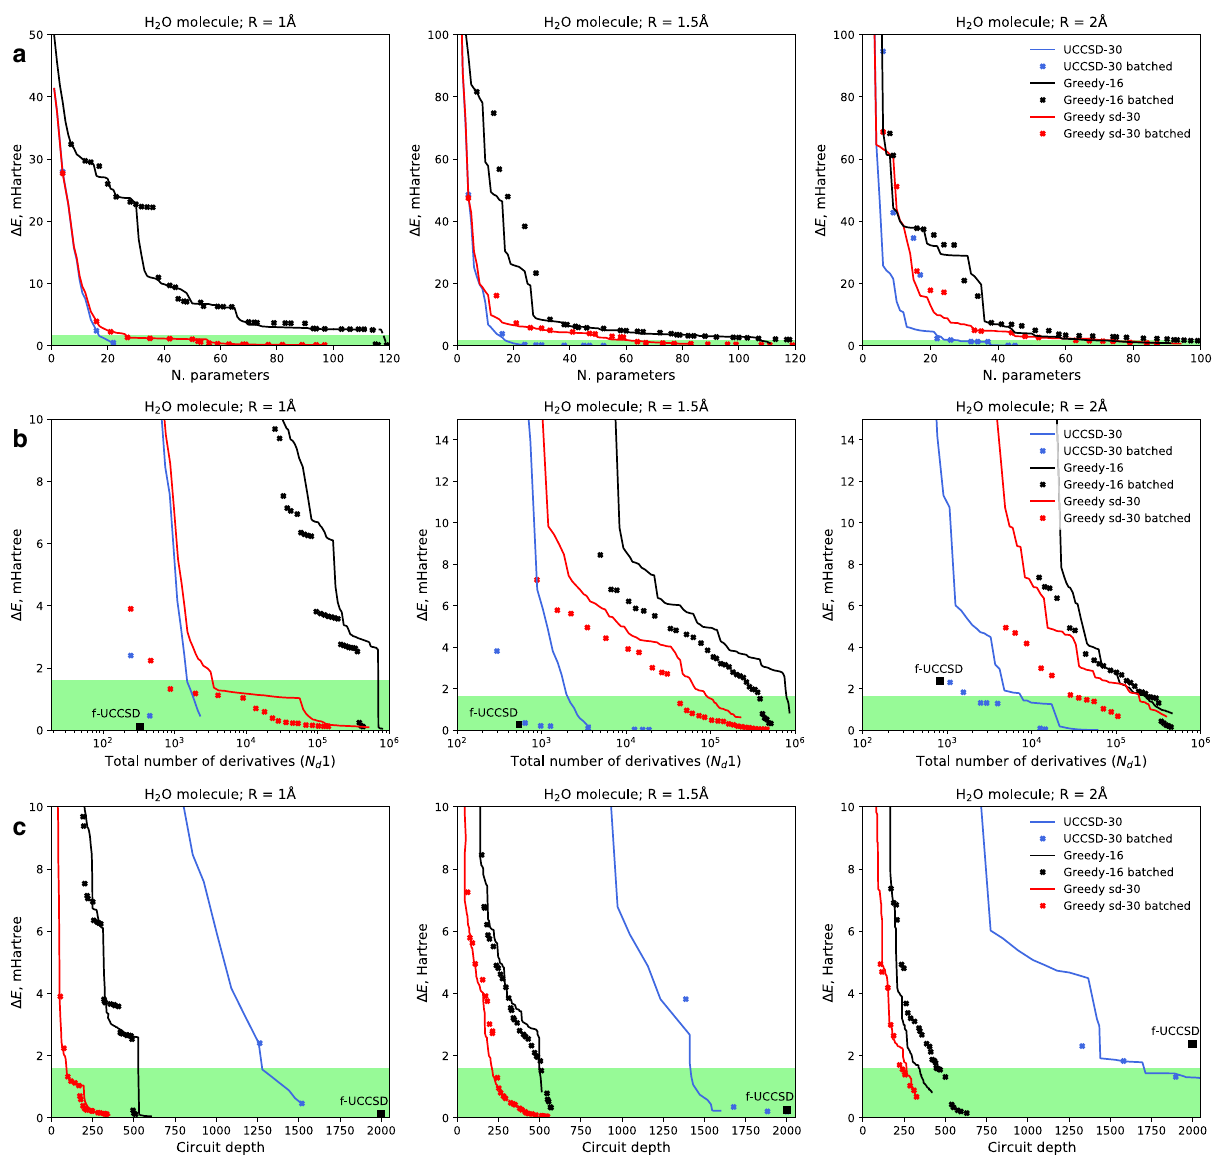
Fig. 5 ADAPT-VQE and VQE-UCCSD convergence of the energy with respect to the number of parameters, total number of derivatives and circuit depth for H 2 O molecule at various bond lengths. Fermionic ADAPT-VQE results are marked as "UCCSD- N '', where N indicates the size of the fermionic pool with single and double excitations. Qubit ADAPT-VQE results are referred to as Greedy- N (qubit linear complete pool) and Greedy sd- N (qubit polynomial complete pool with Pauli strings originated from each single and double fermionic excitation), where N is the qubit pool size. "f-UCCSD" refers to VQE-UCCSD result. With the green color we highlight the area, where the chemical accuracy threshold is satis fi ed. a Energy convergence with respect to the number of parameters for ADAPT-VQE and VQE-UCCSD. b Energy convergence with respect to the total number of derivative evaluations N d 1 for ADAPT-VQE and VQE-UCCSD. c Energy convergence with respect to the circuit depth for ADAPT-VQE and